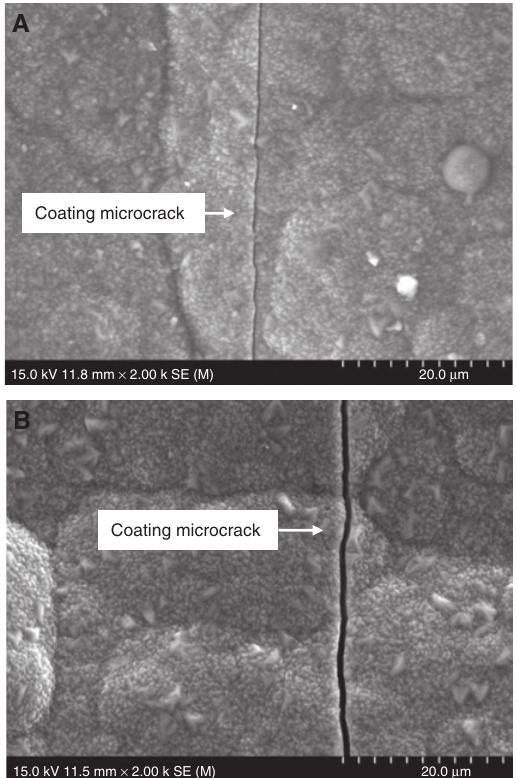
Figure 2 The morphologies of the SiC coating of the two com- posites: (A) the coating microcrack of sample A, (B) the coating microcrack of sample B.